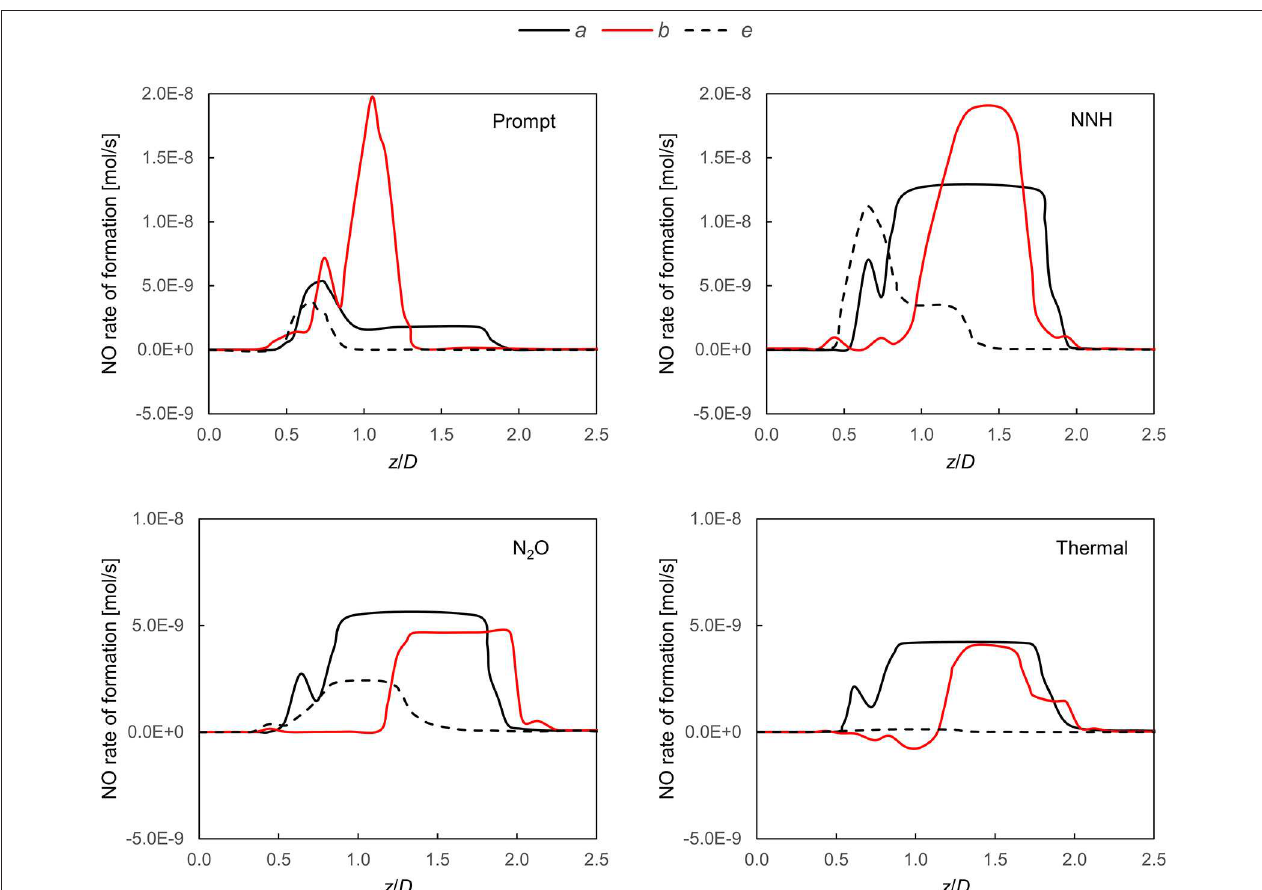
FIGURE 14 | NO formation rates at r = 15mm along the axial direction for the different formation pathways. Values presented for conditions a ( φ ∼= 0.91), b ( φ ∼= 0.77), and e ( φ ∼= 0.53).